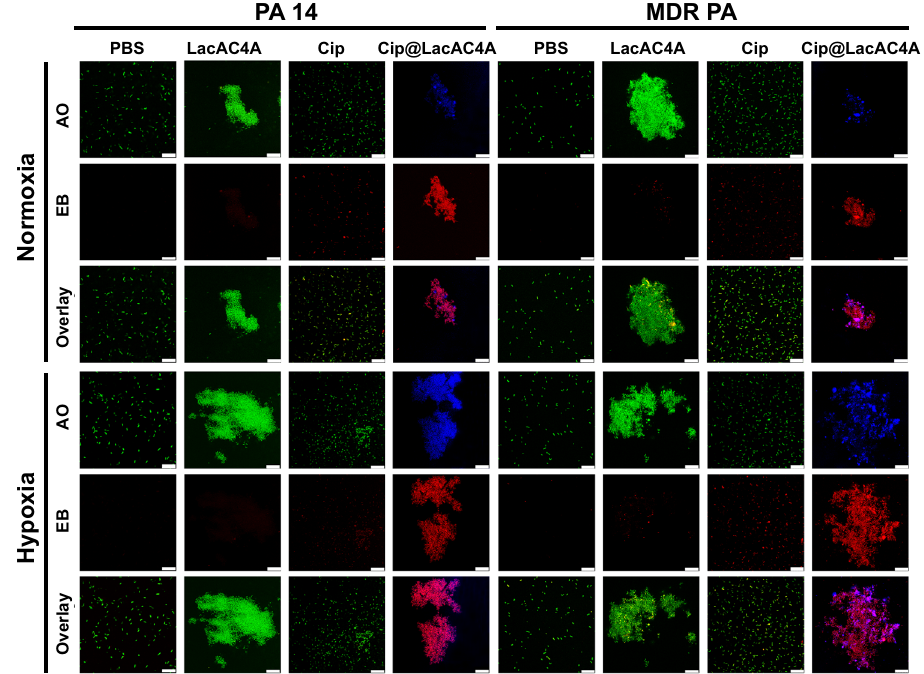
Fig.4|TheantibacterialapplicationanddrughypoxicreleaseofLacAC4A. CLSMimagesofPA14andMDRPAafterdifferenttreatmentsundernormoxicandhypoxic conditions. Scale bar was 25 μ m. Green represented AO, red represented EB, blue represented